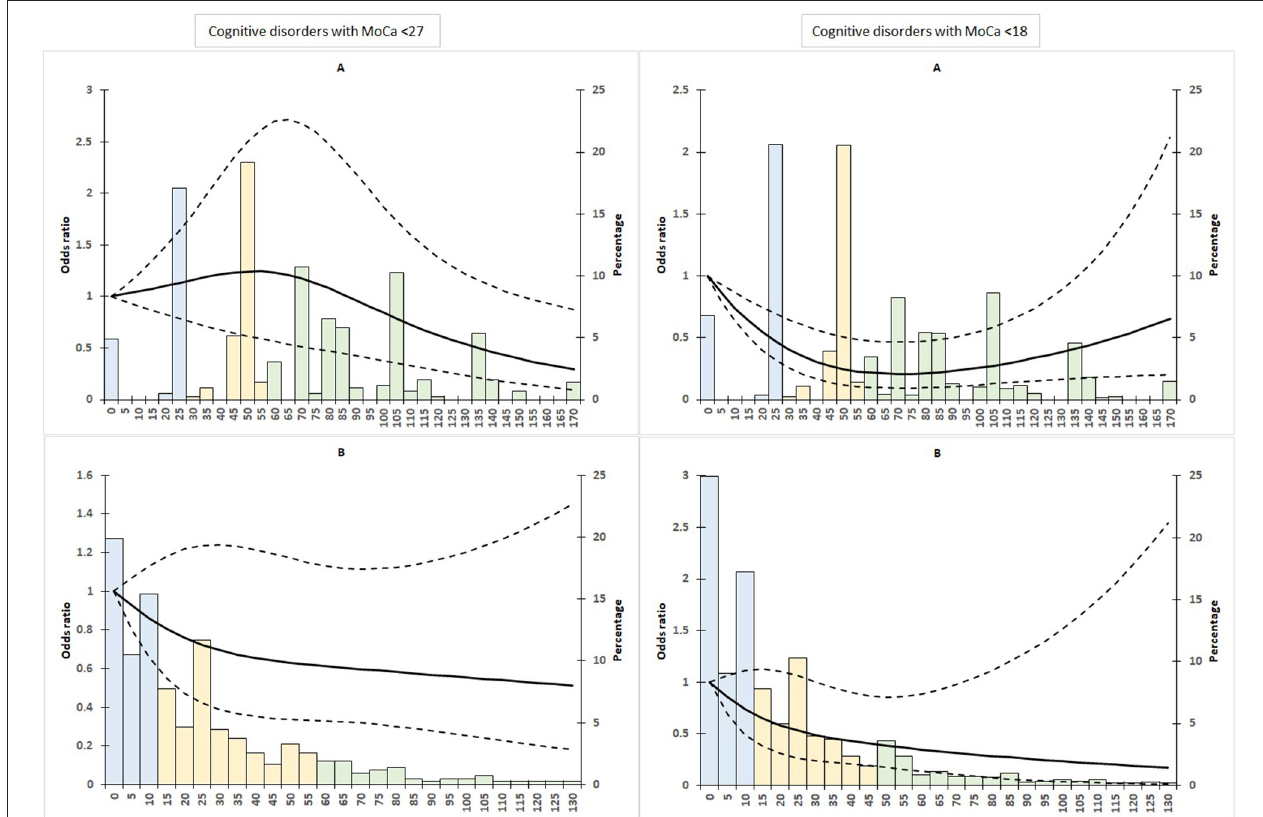
FIGURE 1 | Adjusted (age, gender, years of education) spline analyses of cognitive decline risk (MoCA) by domestic activities (A) and leisure activities (B) . Dashed lines represent 95% confidence intervals. The score distribution is represented by the histogram in the background with the blue bars for the reference class, the yellow bars for the moderate activity class and the green bars for the high activity